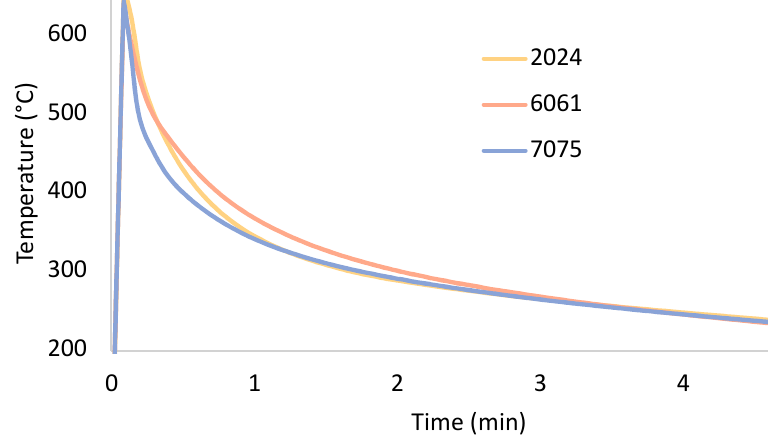
Figure 1. Temperature as a function of time for each alloy during casting.